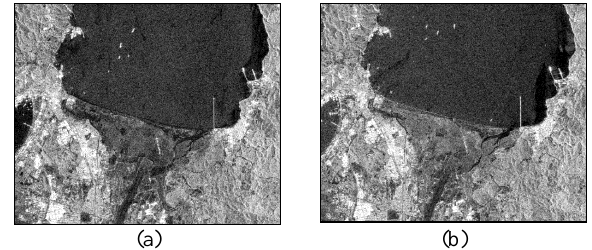
Figure 6. Result images after backscattering processing: